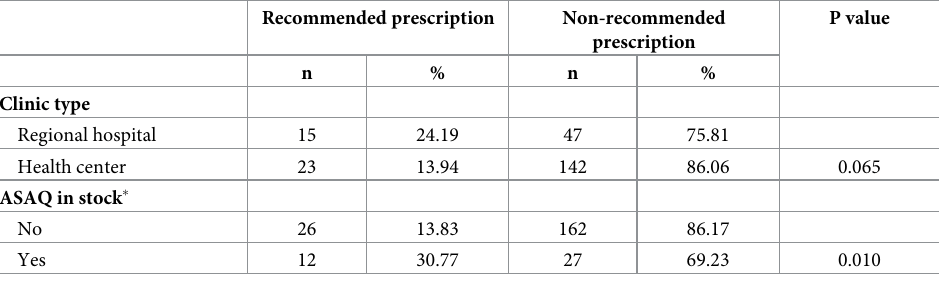
Table 5. Health facilities related